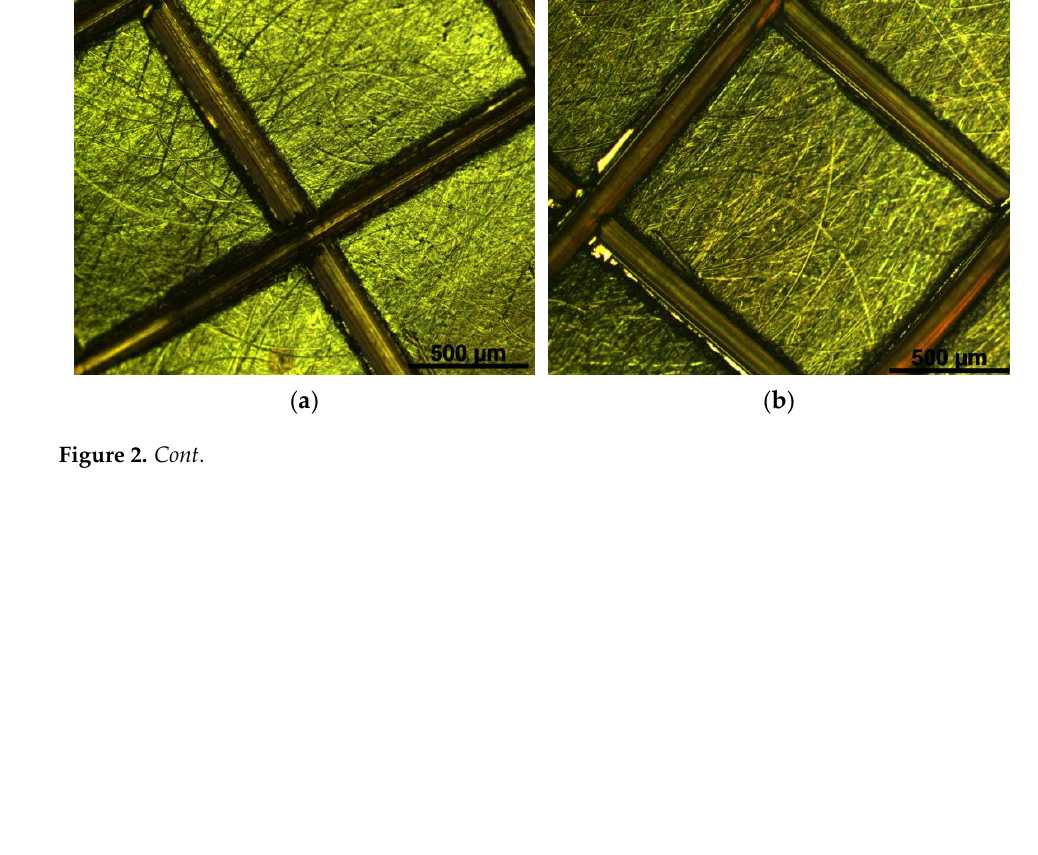
Figure 1. SEM image of the surfaces and sections of the tin plating layer ( a , c , e , g ) containing cerium nitrate; ( b , d , f , h ) not containing cerium nitrate.